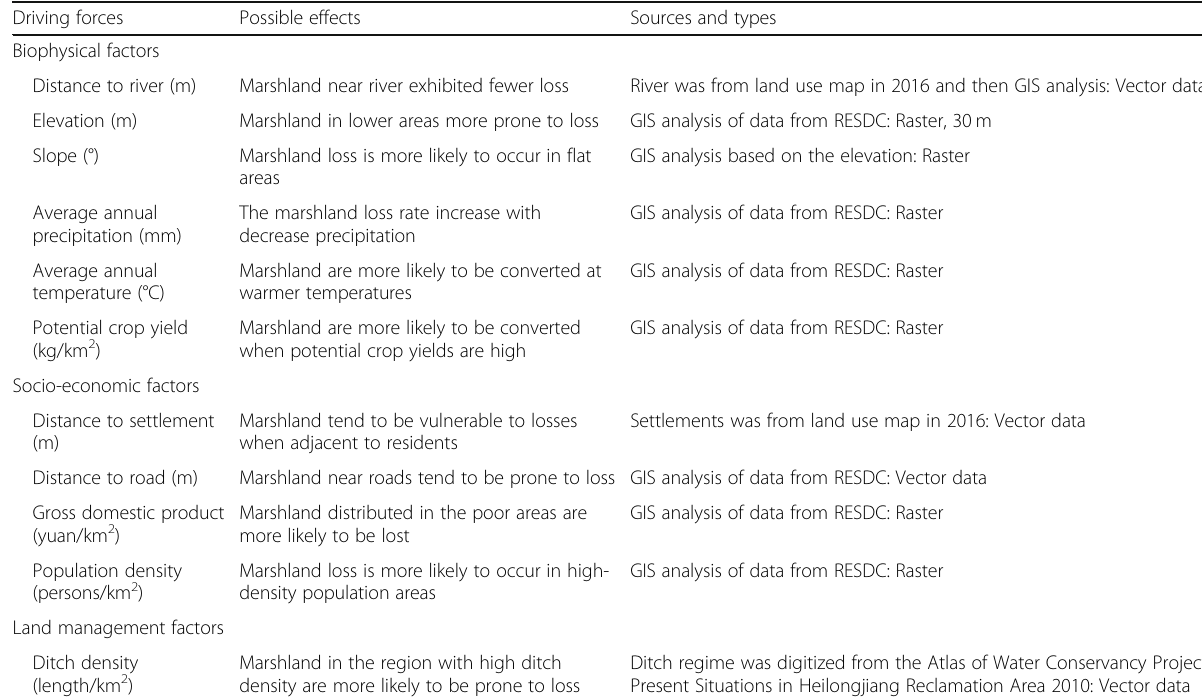
Table 2 Driving forces and possible effects Driving